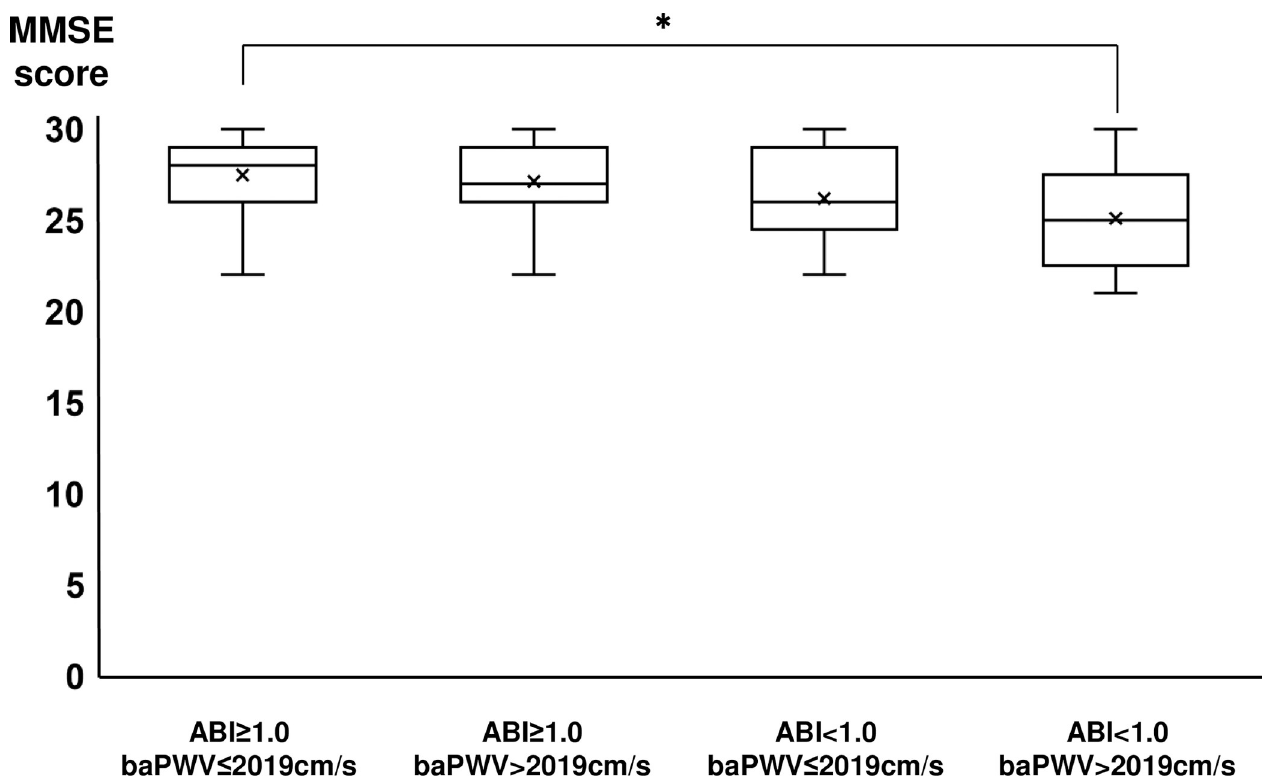
Fig 2. Comparison of the MMSE scores among the four groups: ABI � 1.0 and baPWV � 2019 cm/s, ABI � 1.0 and baPWV > 2019 cm/s, ABI < 1.0 and baPWV � 2019 cm/s, and ABI < 1.0 and baPWV > 2019 cm/s. The MMSE score significantly decreased with lower ABI and higher baPWV (p < 0.05). Bonferroni correction and Tukey’s HSD tests revealed that the MMSE scores for the group with ABI < 1.0 and baPWV > 2019 cm/s were significantly lower than those for the group with ABI � 1.0 and baPWV � 2019 cm/s. MMSE, Mini-Mental State Examination; ABI, ankle-brachial pressure index; baPWV, brachial-ankle pulse wave